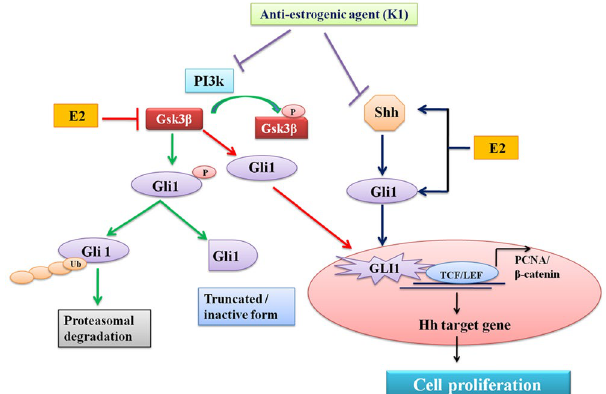
Figure 8. Schematic representation of functional involvement of Hh signaling molecules in estrogen- mediated endometrial hyperplasia. Exposure of estrogen induces activation of Gli1 via canonical pathway. Estrogen attenuates the Gsk3 β protein expression leading to activation of Gli1which induces various target genes involved in cellular proliferation of estrogen-mediated hyperplasia progression. Anti-estrogenic agent (K1) counteracts Gli1expression via both canonical (ligand dependent) such as inhibition of Shh and non- canonical pathway (ligand independent) as activation of Gsk3 β . Activation of Gsk3 β might promote Gli1 phosphorylation i.e., its inactivation or proteasomal degradation 32, 57, 58